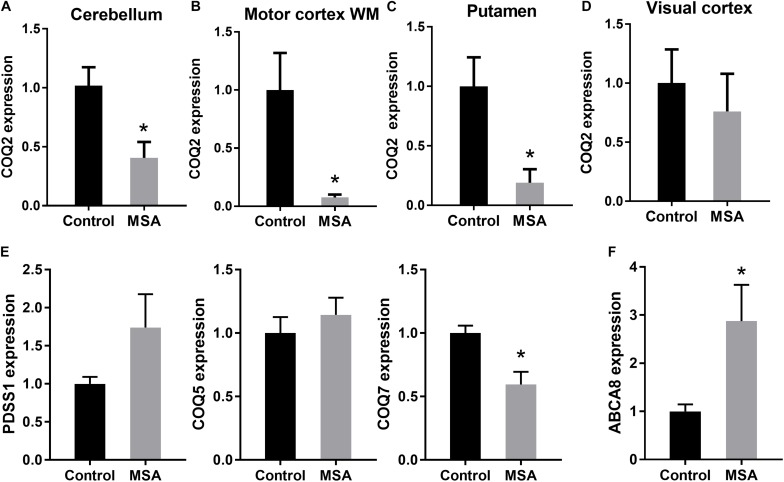
Expression of the main biosynthetic enzymes in coenzyme Q10 production. COQ2 mRNA expression in disease-affected regions cerebellum (A), white matter underlying motor cortex (B) and putamen (C) and disease-unaffected region visual cortex (D) of MSA and control brains. (E) PDSS1, COQ5 and COQ7 mRNA expression in the cerebellum of MSA and control brains. (F) ABCA8 mRNA expression in the cerebellum of MSA and control brains. Data represent mean of MSA (n = 8) and control (n = 10) brains, and SE as error bars, ∗p < 0.05.